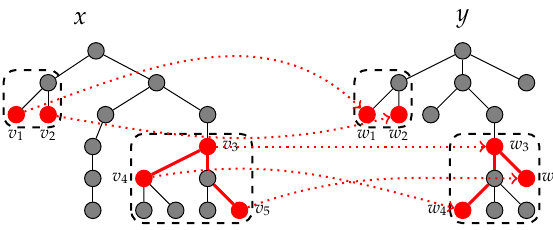
Figure A3. A separable mapping { ( v i , w i ) } i = 1,1...,5 ∈ M S x , y .